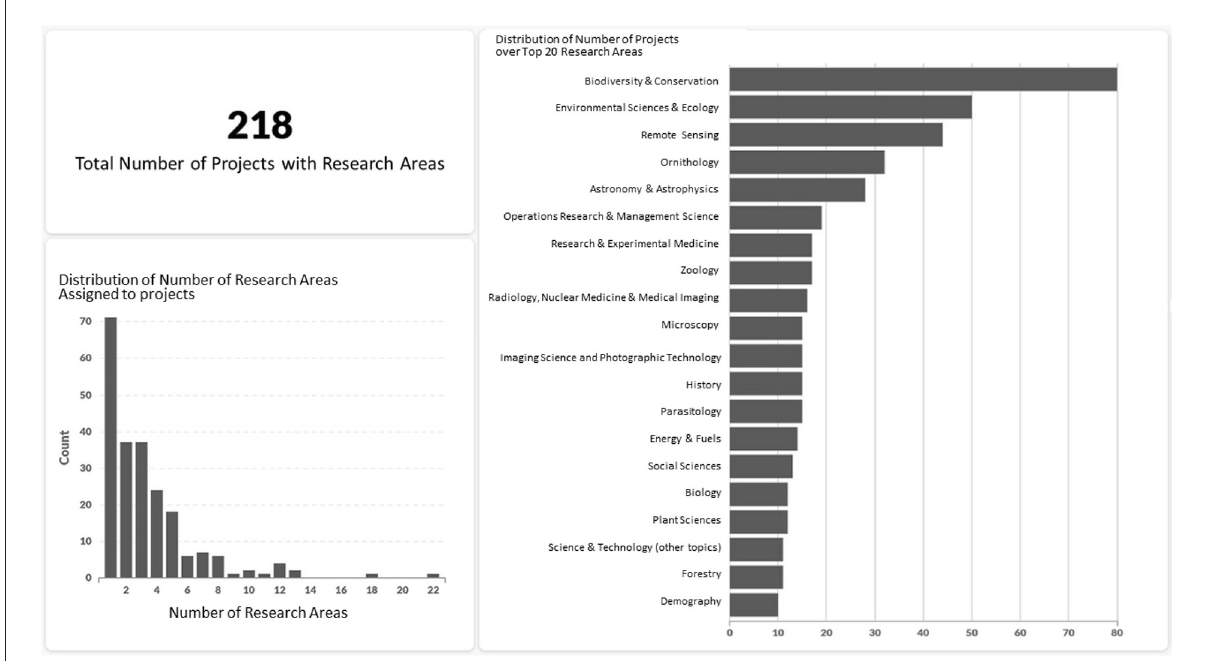
FIGURE2 Dashboard visualizing the results of the research areas analysis for projects in the CS Track database. The selection of projects was limited to 218 Zooniverse